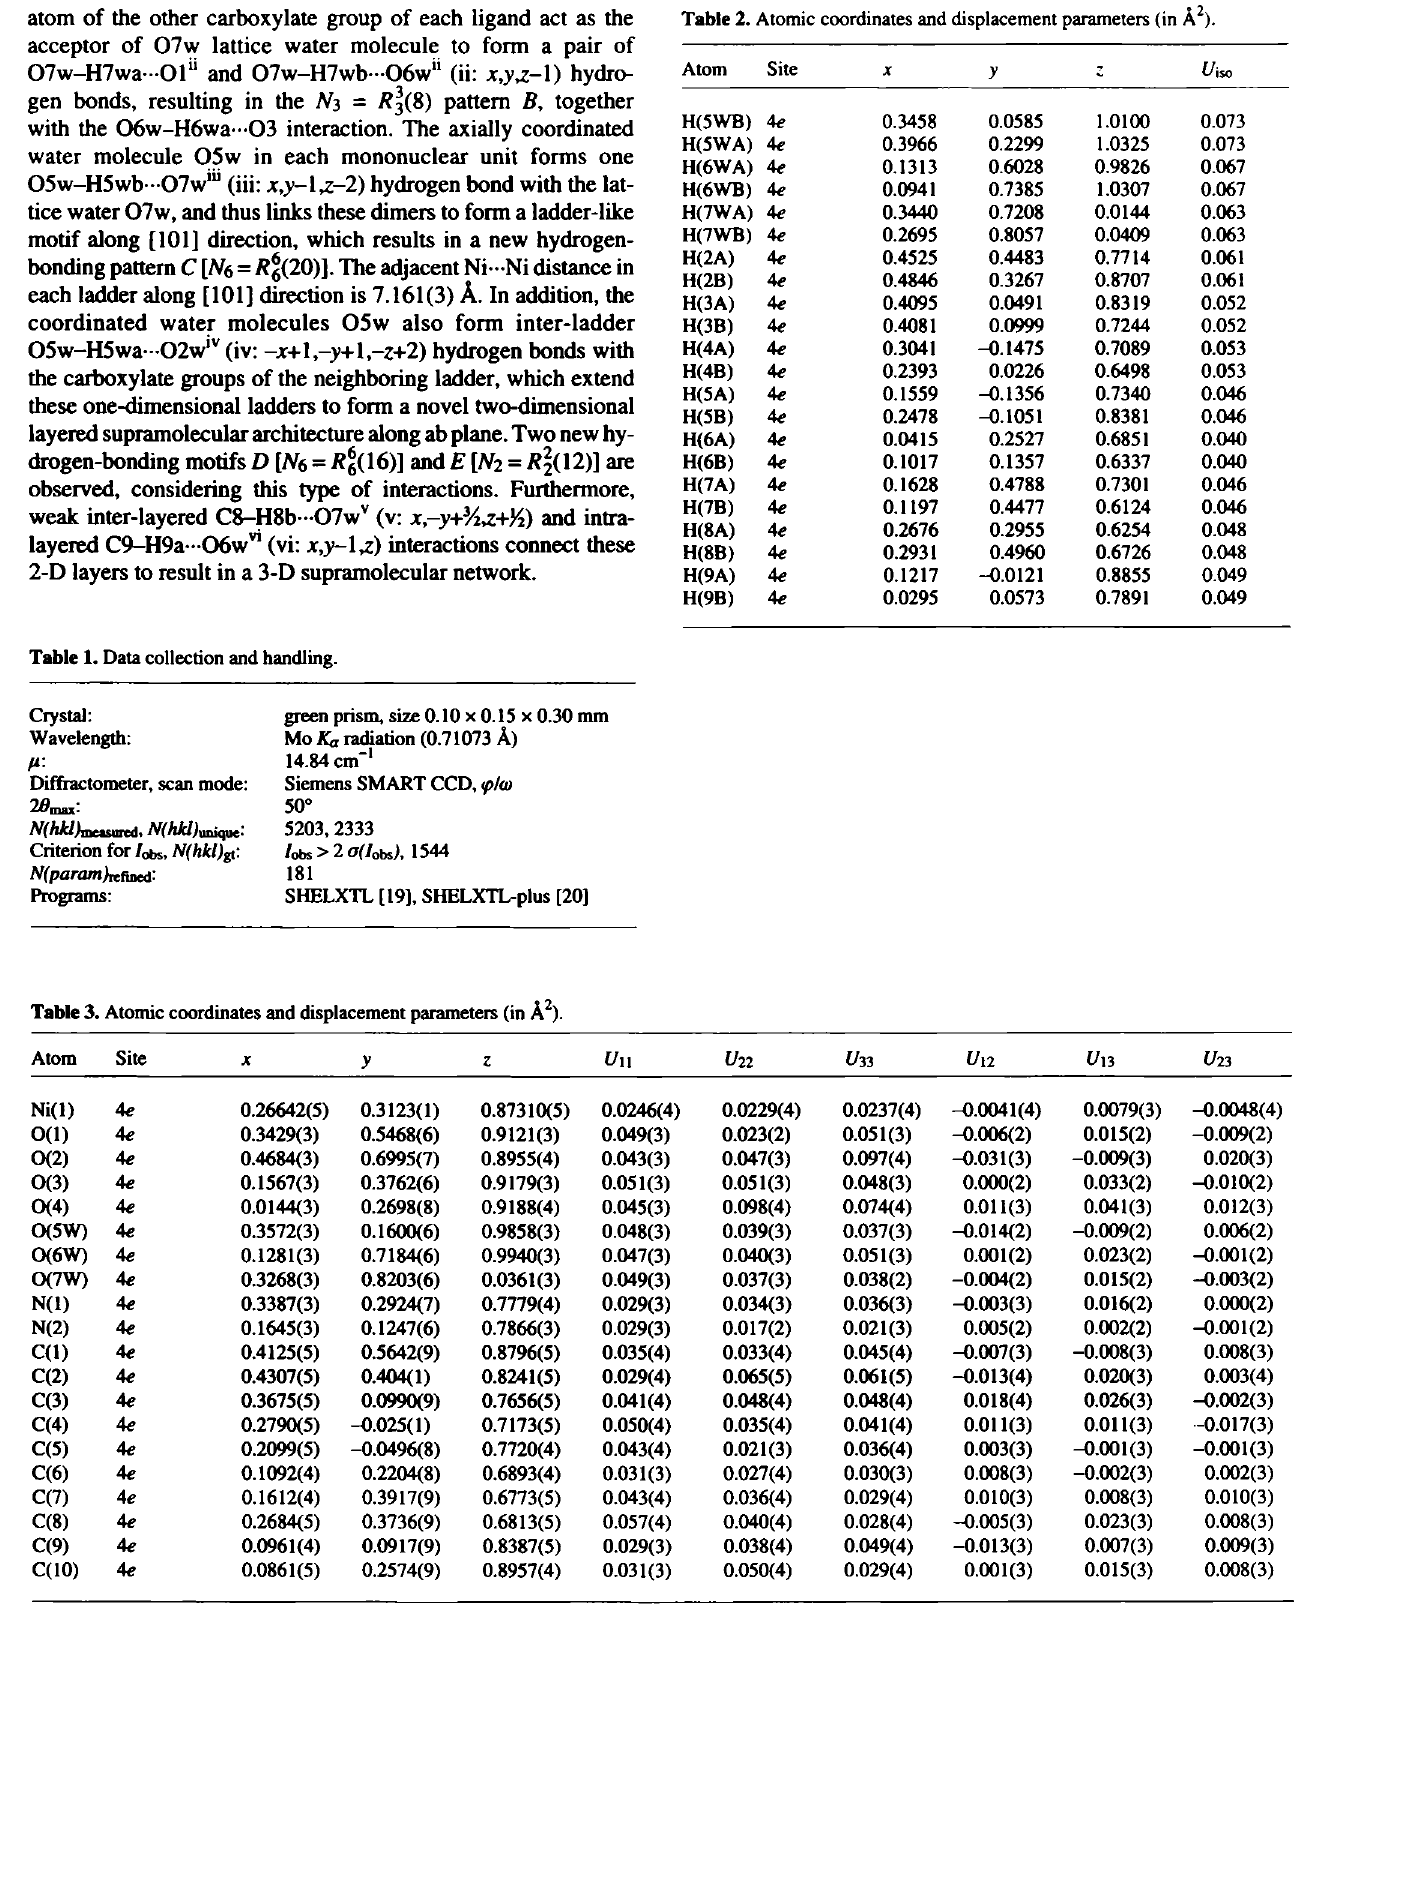
Table 2. Atomic coordinates and displacement parameters (in A 2 ).